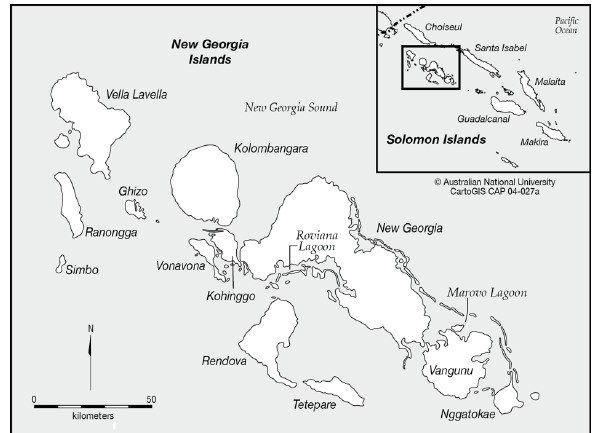
Fig. 2 . New Georgia Island group, Western Province.